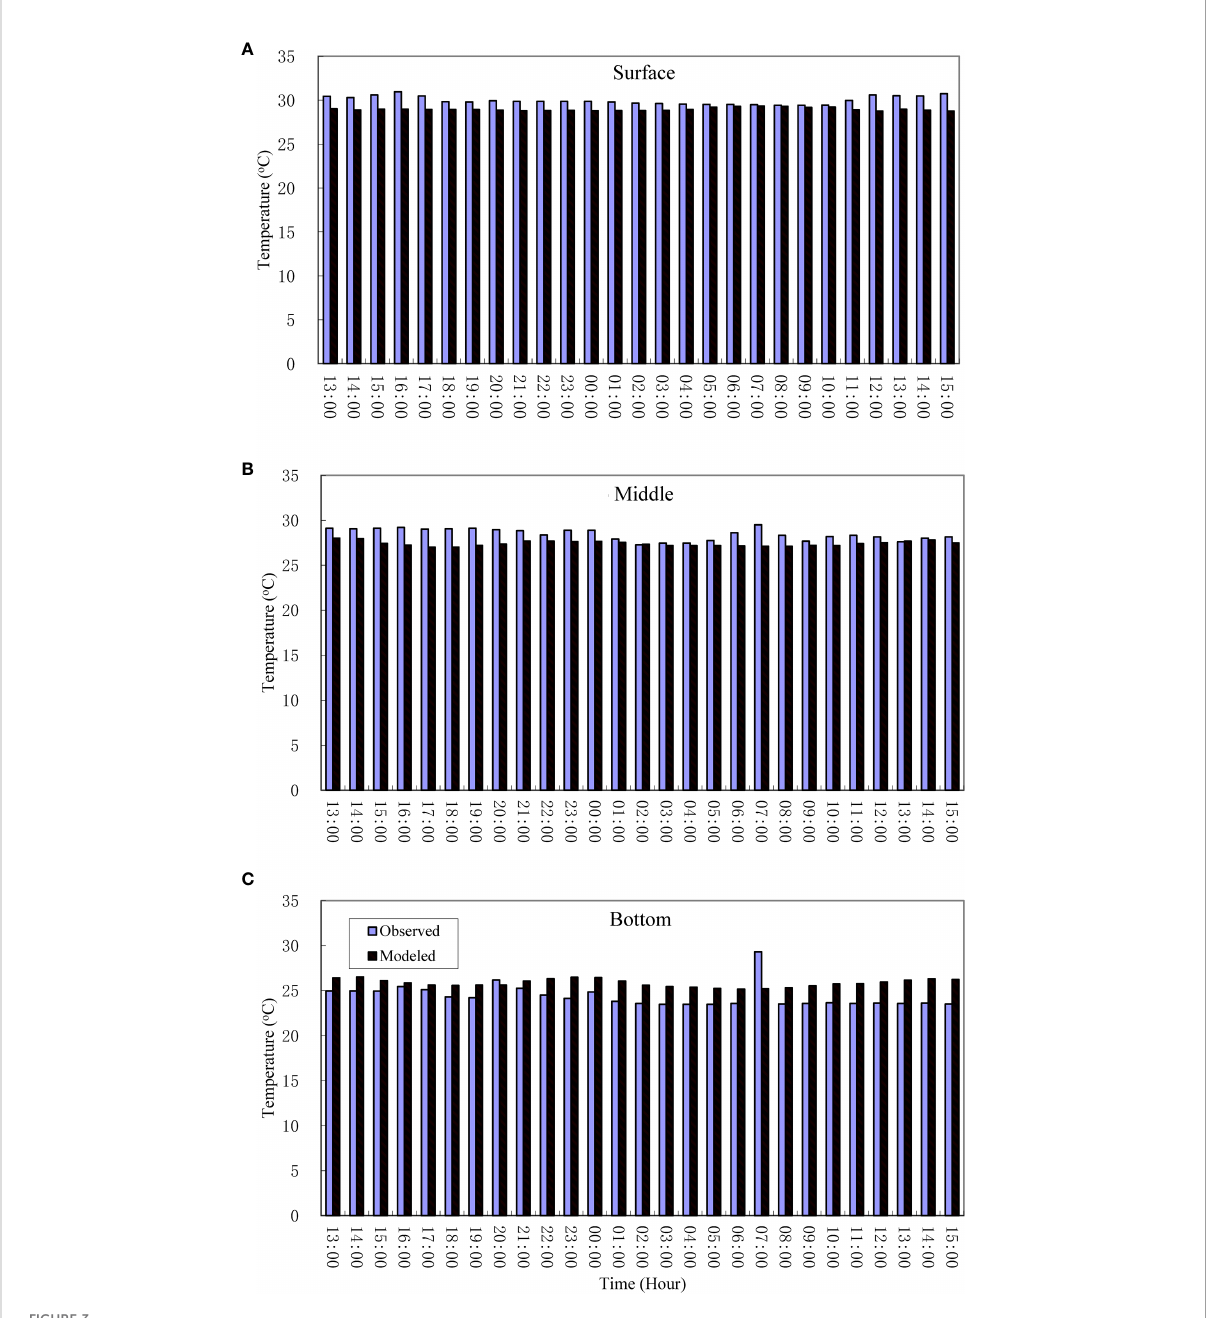
FIGURE 3 Comparisons of modeled temperature with fi eld observations at stations T1: (A) Surface; (B) Middle layer; and (C) Bottom layer. The fi eld observations conducted at September 12 and 13,